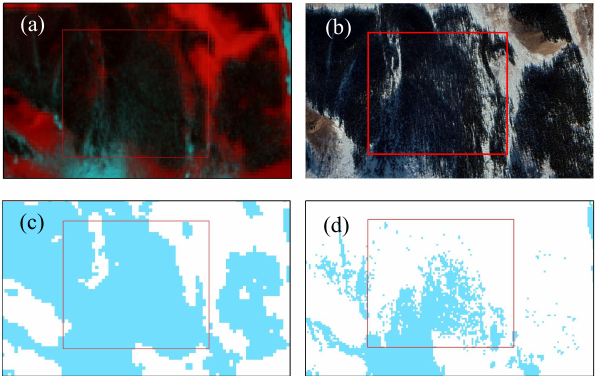
Figure 12 . Spatial differences of snow cover extraction results in forest areas: (a) Sentinel-2 false color image; (b) Google Earth image; (c) dynamic threshold extraction snow cover results; (d) fixed threshold extraction snow cover